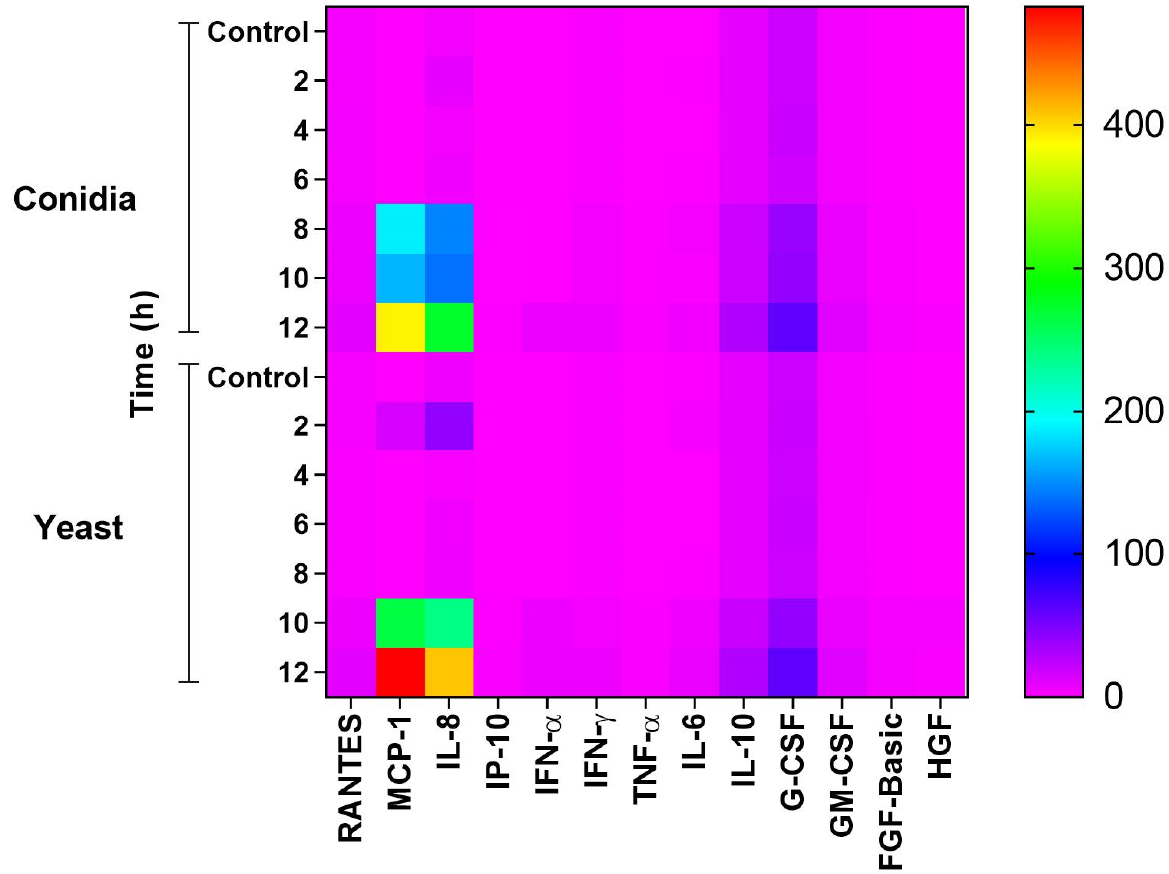
Figure 8. Heat map of cytokine, chemokine and growth factor production during infection of keratinocytes by conidia and yeast cells of S. schenckii. Production of different mediators was analyzed using the Luminex Technology. The supernatants of the keratinocytes infected with conidia and yeasts of the fungus S. schenckii were used at different post-infection times. The results are presented as the mean of two independent experiments of the concentration values (pg/mL) of each mediator analyzed.